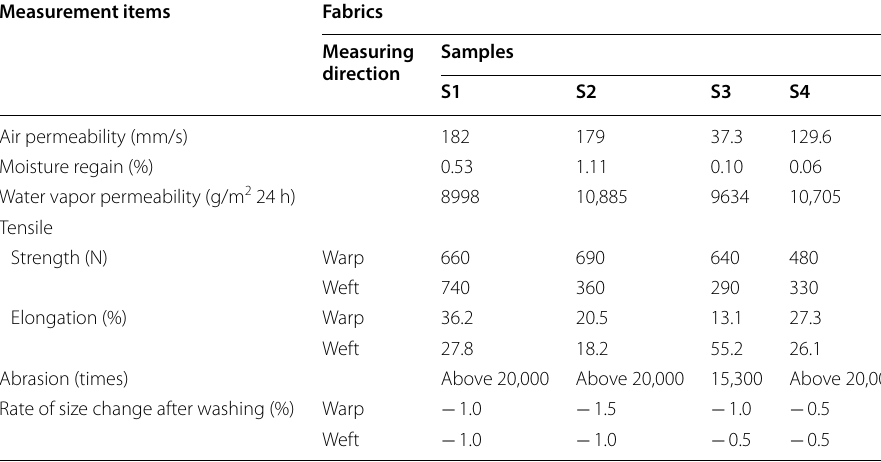
Table 2 Comparison of properties of fluorescent fabric